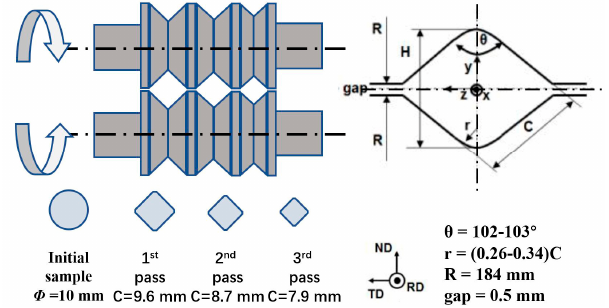
Figure 1. Schematic illustration of 3-pass caliber rolling. RD: rolling direction; ND: normal direction; TD: transverse direction.